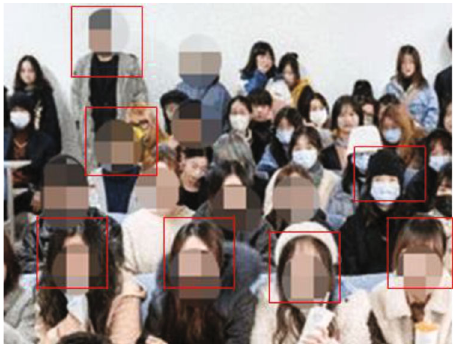
Figure 1: Initial location of each student.